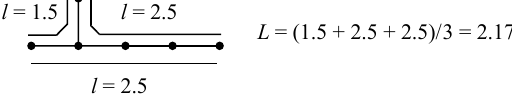
Figure 11. Counting of L for a conjugated acyclic polyene radical.